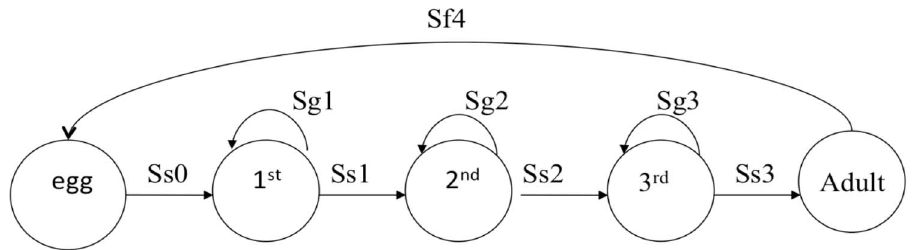
Figure 2. Ohlone tiger beetle stage class population model. The parameters presented are those we measured: survival of egg to 1 st instar (Ss0), growth of 1 st instar (Sg1), survival of 1 st to 2 nd instar (Ss1), growth of 2 nd instar (Sg2), survival of 2 nd to 3 rd instar (Ss2), growth of 3 rd instar (Sg3), survival of 3 rd instar to adult (Ss3), and fertility of adults (Sf4).